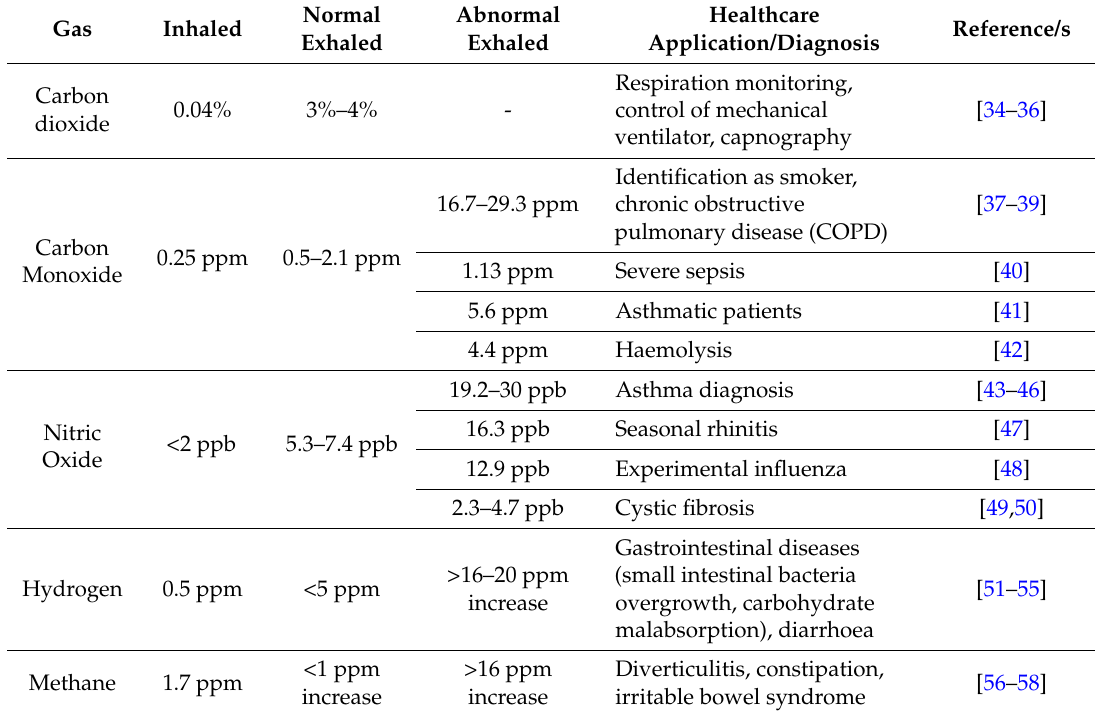
Table 1. List of gases found in exhaled breath and their diagnostic